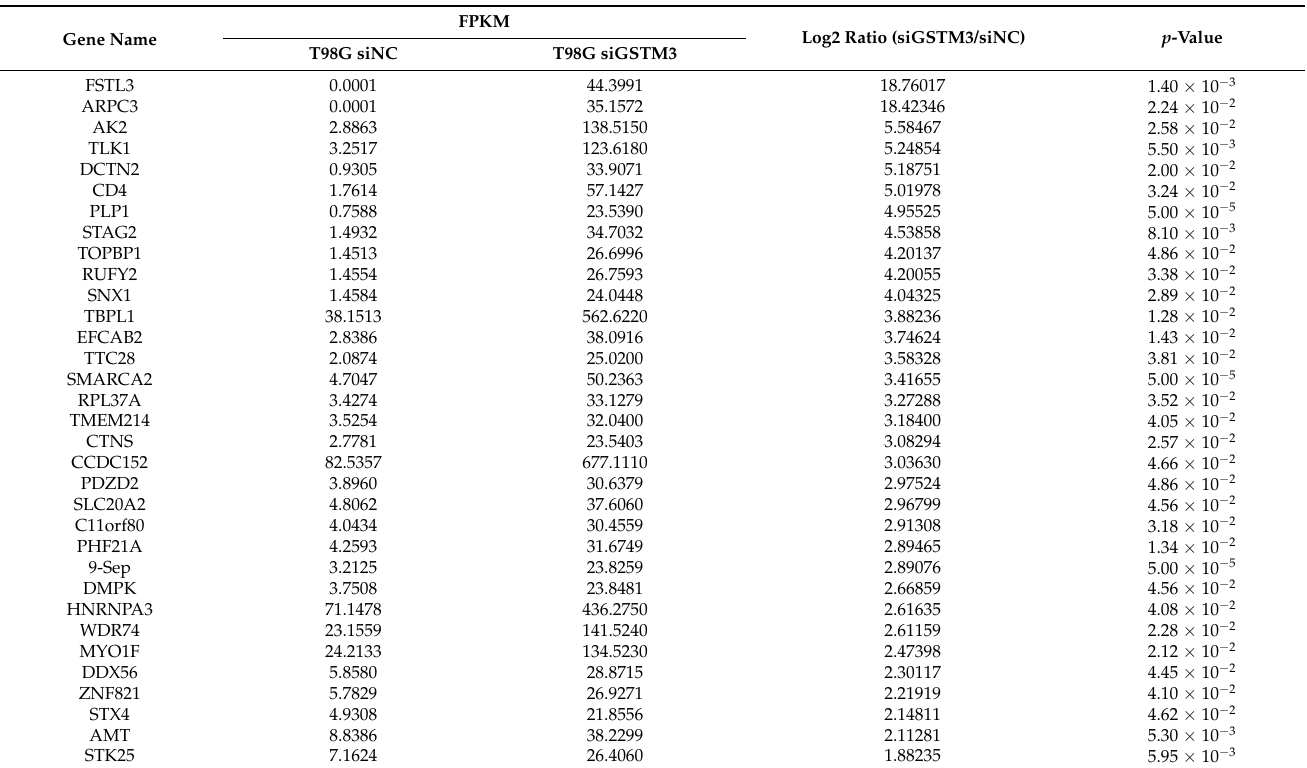
Table 1. The upregulated mRNAs revealed in GSTM3 knockdown T98G.